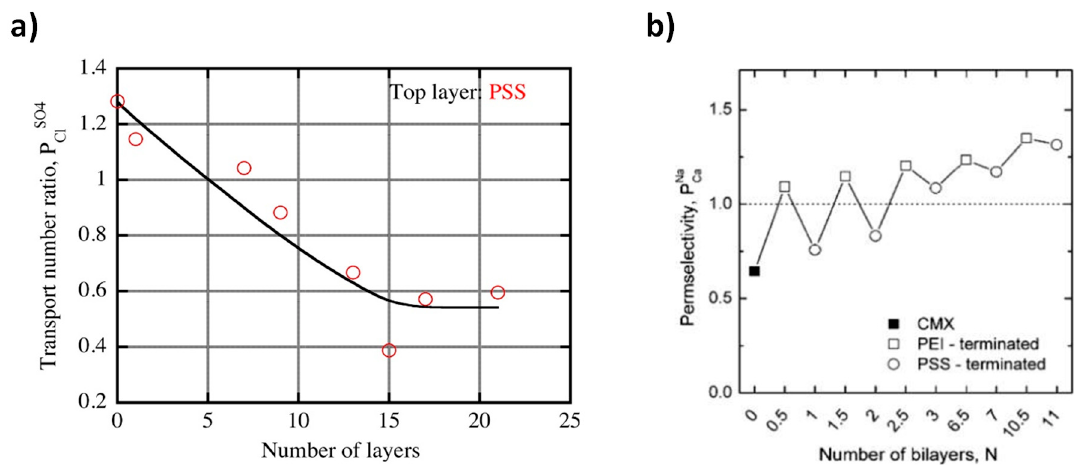
Figure 9. ( a ) The transport number ratio of SO 42- and Cl - ions in ED as a function of the number of layers for the AMX membrane modified with PSS end layers [51]. ( b ) Variations in the permselectivity of the Neosepta CMX with the number of PEI/PSS bilayers [54]. Reproduced with permission